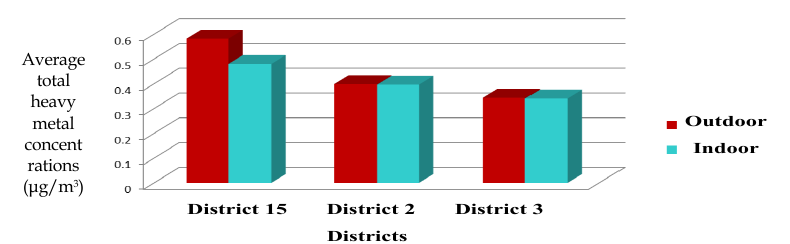
Figure 3. Average heavy metal concentrations in outdoor/indoor spaces of high-traffic districts in Tehran, Winter 2018